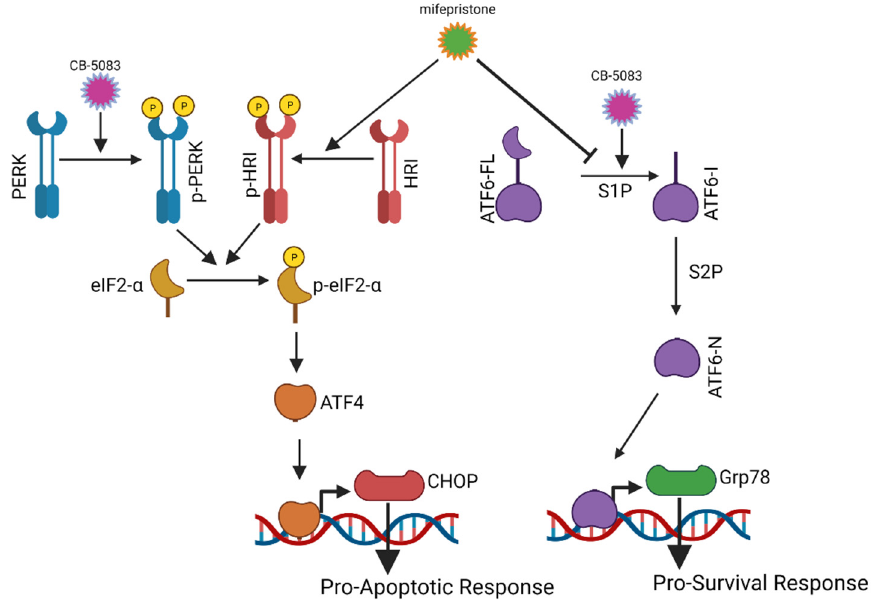
Figure 8. Putative mechanism for synergistic cytotoxicity between CB-5083 and mifepristone. Treatment with VCP inhibitor-CB-5083 activates the activating transcription factor 6 (ATF6) branch and the protein kinase R-like endoplasmic reticulum kinase (PERK) branch. Activation of ATF6 can result in the induction of glucose-regulated protein 78 (Grp78). Induction of Grp78 is considered a pro-survival response. Similarly, PERK activation can ultimately induce CCAAT/enhancer-binding protein homologous protein (CHOP). Enhanced expression of CHOP can be a pro-apoptotic response. Mifepristone treatment inhibits the ATF6 branch and enhances CHOP expression through the activation of the heme-regulated inhibitor (HRI) kinase pathway. The combination of these two effects could result in the enhanced cytotoxicity seen with CB-5083 and mifepristone combination. We also observed synergistic effects between CB-5083 and mifepristone in IGROV1